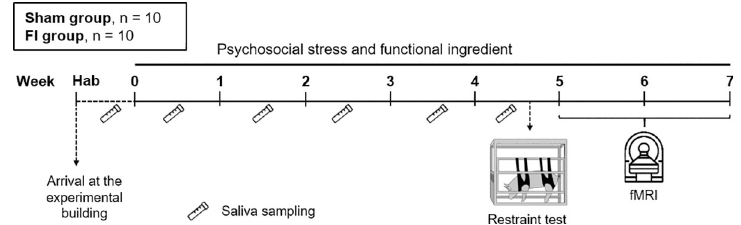
Fig 1. Experimental paradigm. At their arrival at the experimental building, pigs had one week (habituation, hab) to get used to their new environment and feed, and were then subjected to the psychosocial stress consisting in social isolation combined with environmental impoverishment and unpredictability, and to the functional ingredient. Depression-like behaviour was assessed in Week 5 in a restraint test. Saliva samples were collected 6 times, from the habituation week to Week 4. fMRI study was then conducted between Weeks 5 and 6 to investigate the effects of the supplementation with the functional food ingredient on brain responses to this ingredient and to an acute pharmacological